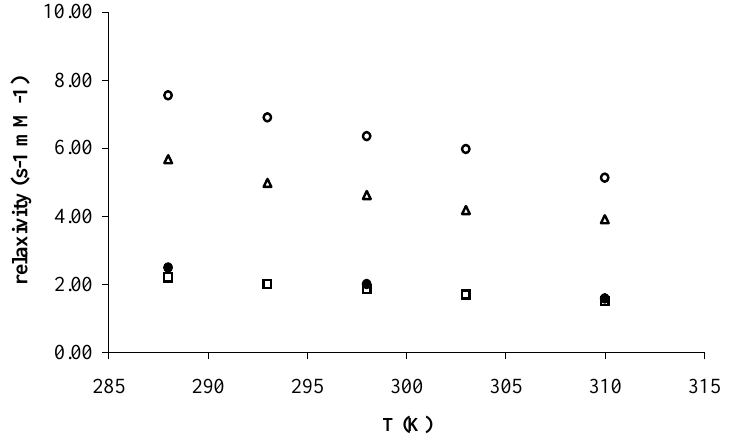
Figure 2. Temperature dependence of the proton longitudinal relaxivity of the water solution 1 mM of ) Gd(III)-1 , ) Gd(III)-dtpa , ) Gd(III)-2, and ) Gd(III)-dota at pH ~ 7 and 60